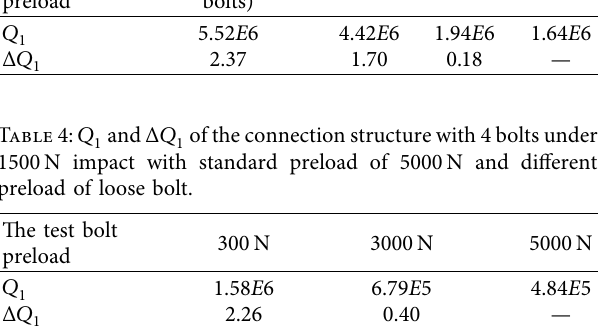
Table 3: Q and Δ Q of the connection structure with 6 bolts under 1 1 1500N impact load with standard preload of 5000N and different preload of loose bolt.